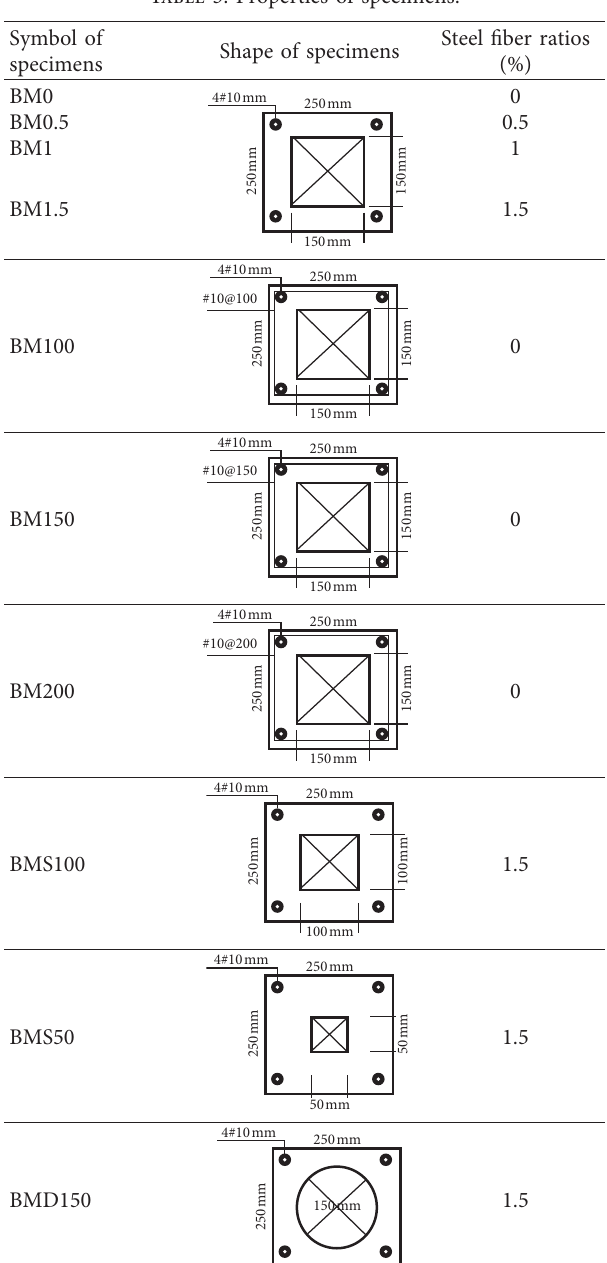
Table 3: Properties of specimens.